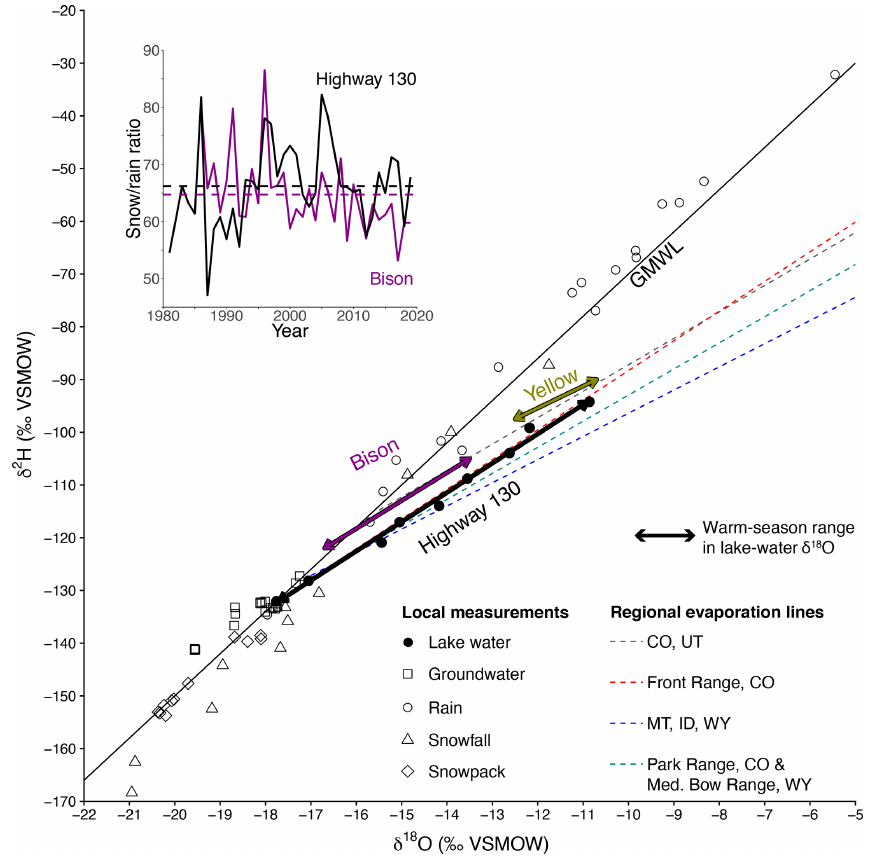
Figure 2. Modern measurements of δ 18 O and δ D. Samples from the study watershed shown here were collected throughout 2017. Regional evaporation lines (dashed lines; Henderson and Shuman, 2009; Anderson et al., 2016) intersect the global meteoric water line and represent the linear regression of lake-water isotope compositions in a region. Isotopic measurements from the study watershed (open symbols) show the range in isotope compositions of hydrologic inputs to Highway 130 Lake from the watershed. Arrows represent the range in modern δ 18 O and δ D values of Highway 130 Lake (black), Bison Lake (purple; Anderson, 2011), and Yellow Lake (yellow; Anderson, 2012) throughout the ice-free season, and black dots show the individual measurements at Highway 130 Lake. The inset plot shows the modern annual ratio of snow to rain for the SNOTEL stations nearest Highway 130 Lake (black line) and Bison Lake (purple line), and the dashed lines show the